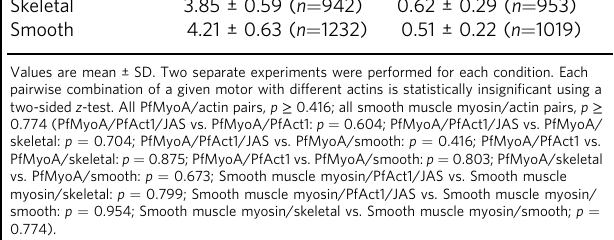
Table 1 In vitro motility speeds of different actin and myosin pairs.